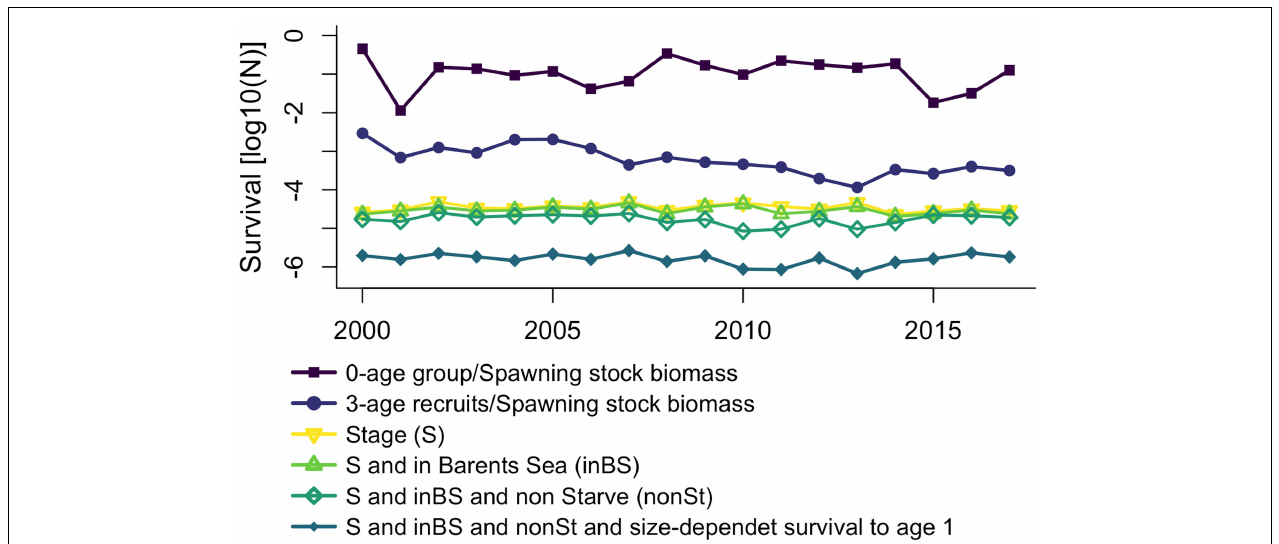
FIGURE 7 | Cumulative modeled survival until the 30th of September only including fixed stage-specific mortality rates (yellow line with upside-down triangles), also adding requirement that individuals need to reach the Barents Sea (green with triangles), also requiring that individuals do not starve (dark green with open diamond) and including size-dependent survival until age 1 (blue line with filled diamonds). For comparison we show observed 0-age group abundance divided by spawning stock biomass (purple line with filled squares) and abundance of 3-year olds from Virtual Population Analysis back-calculated to spawning year divided by spawning stock biomass (SSB - dark blue line with filled circles). Units for the latter two variables are thousands per tones, data from the ICES